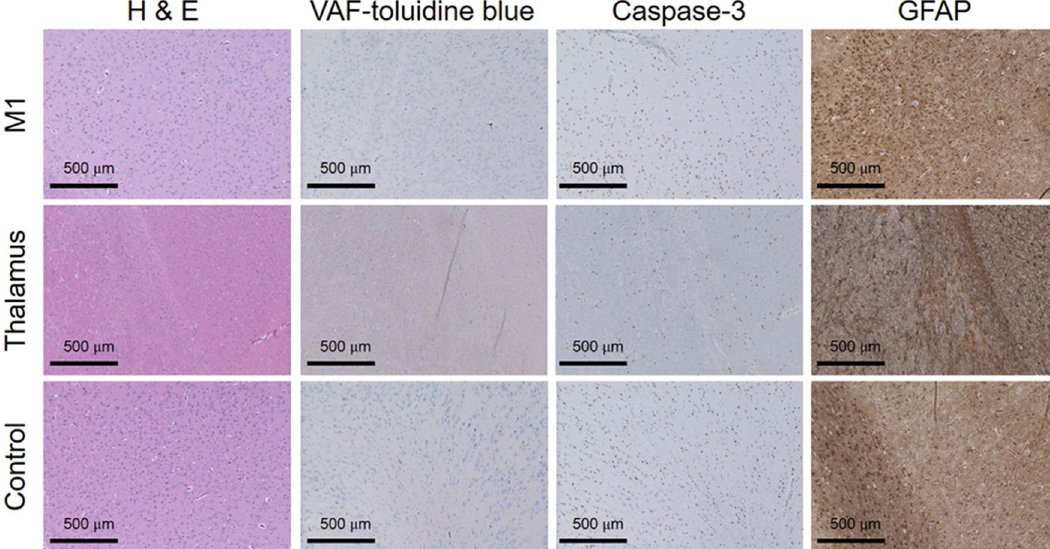
Figure 7. Exemplary histology analysis results of brain tissues. The microscopic images (40 × magnification) of the M1, thalamus, and control sites are displayed across staining methods, H&E, VAF-toluidine blue, Caspase-3, GFAP. No evidence of tissue damage due to FUS sonication is